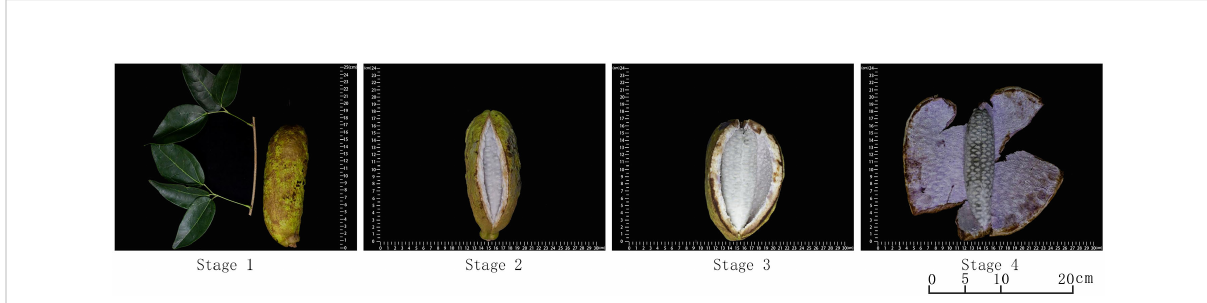
FIGURE 2 Four stages of fruit development of A. trifoliata fruit (taking HY-9 material as an